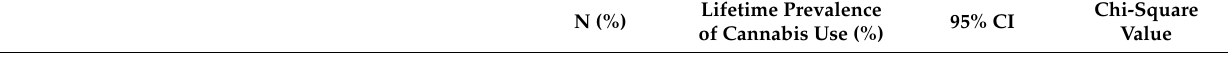
Table 1. Descriptive statistics of demographic, parenting, and confounding